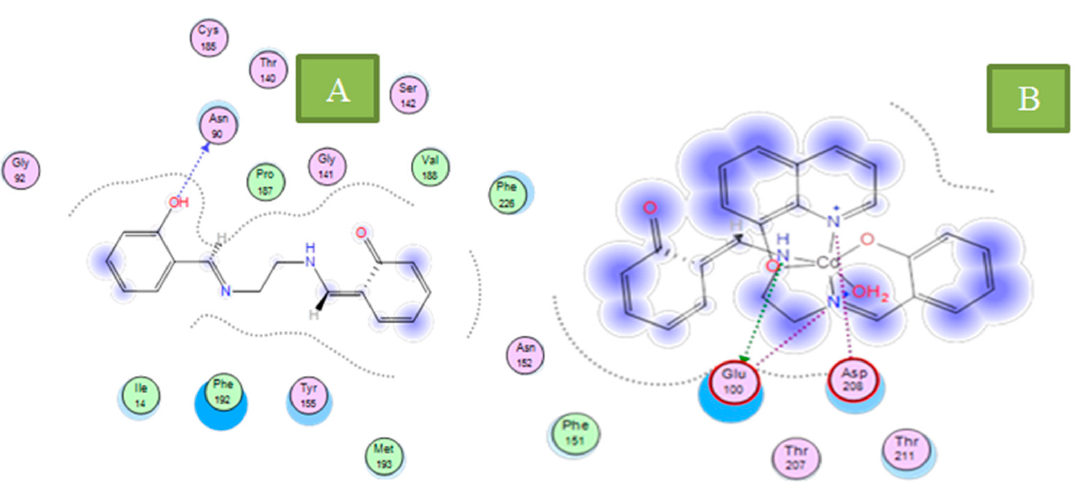
Figure 12. 2D plot of the interaction between the ligand ( A ) and Cd(II) metal complex ( B ) with the active site of the receptor of breast cancer oxidoreductase (PDB ID: 3HB5). Hydrophobic interactions with amino acid residues are shown with dotted curves.